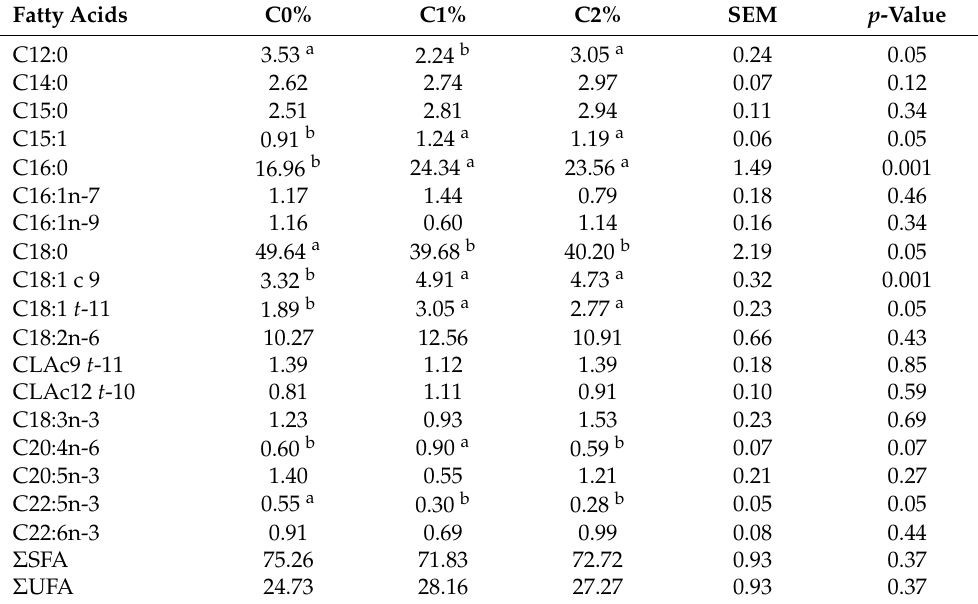
Table 8. Fatty acid composition (g/100 g total fatty acids) of rumen fluid and rate of biohydrogenation at 72 h